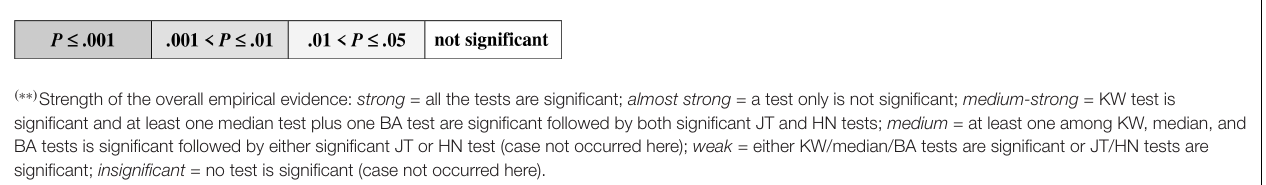
TABLE 3 | Descriptive data (mean and standard deviation) of the ANS proxies within the BMI groups and over the whole set of subjects. Normoweight Overweight Obese Total Vars. Mean